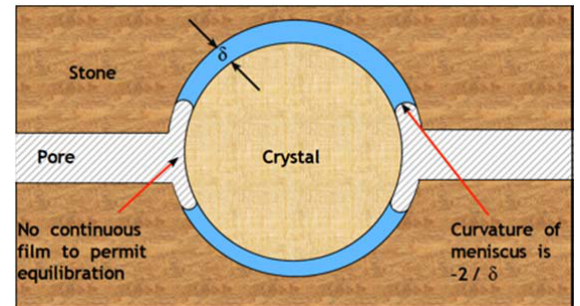
Figure 2. Situation in which drying has proceeded to the point that the meniscus lies between the crystal and the pore wall, so that ions cannot diffuse to the hemispherical end of the crystal. Consequently, the supersaturation in the liquid cannot be relieved by further growth (adapted from